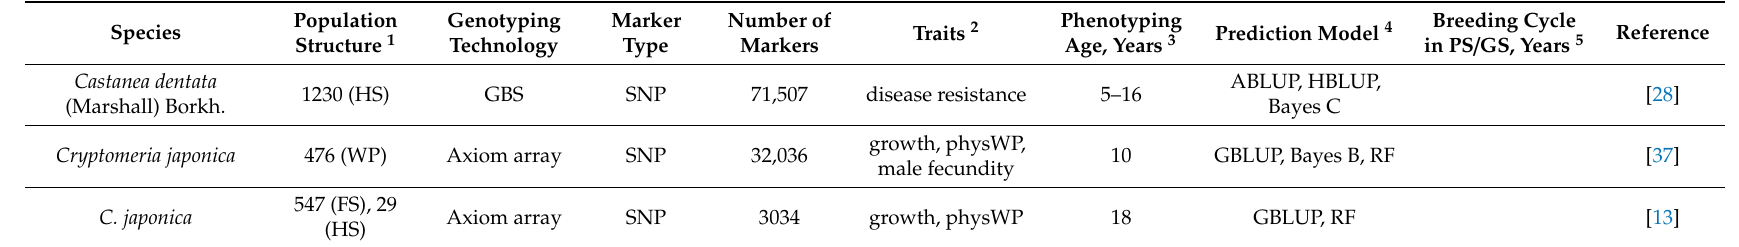
Table 2. Summary of the published experimental studies on GS in forest